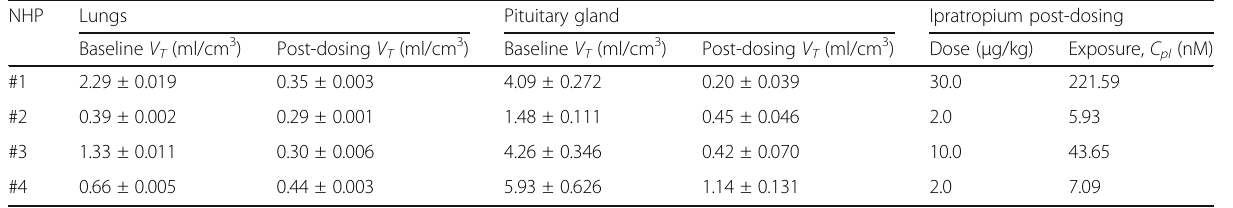
Table 3 Total radioligand binding ( V T ± standard error) in the lungs and pituitary glands; ipratropium intravenous infusion dose and plasma exposure NHP